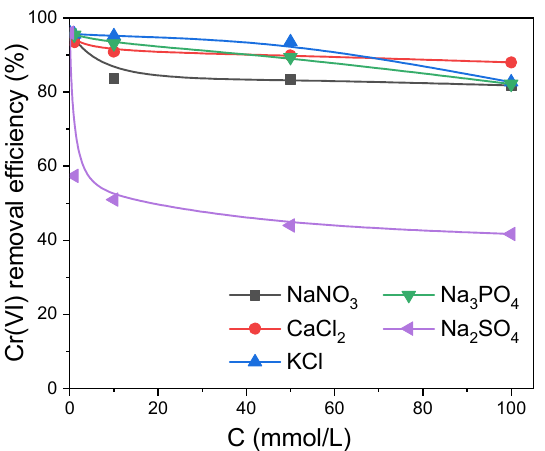
Figure 6. Effect of foreign ions and their ionic strength for Cr(VI) adsorption onto PAN/APNs (T = 298 K, pH = 2, adsorbent = 0.2 g/L, C 0 = 50 mg/L).